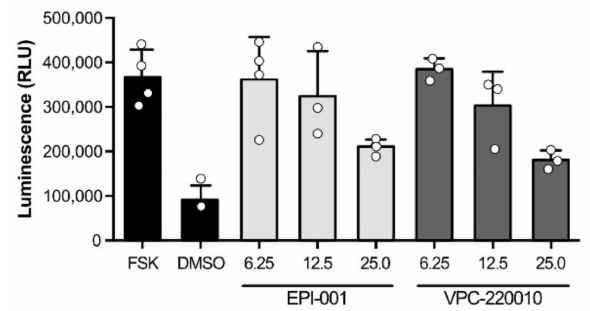
Figure 3. The AR-NTD activation by forskolin was inhibited by EPI-001 and VPC-220010 in a mammalian two hybrid assay. LNCaP cells were co-transfected with AR-NTD fused to a Gal4 DNA binding domain (Gal4DBD-AR 1-558 ) and a reporter gene cloned downstream of the Gal4-binding site before treatment with forskolin (FSK) and varying concentrations of EPI-001 or